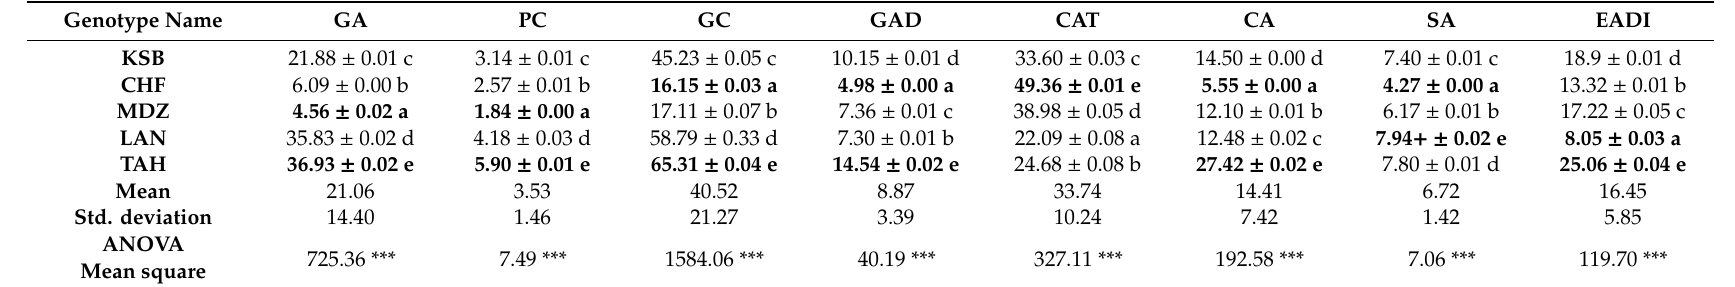
Table 7. Polyphenolic compounds at genotypes site (mean ± SD in mg / 100 DW).